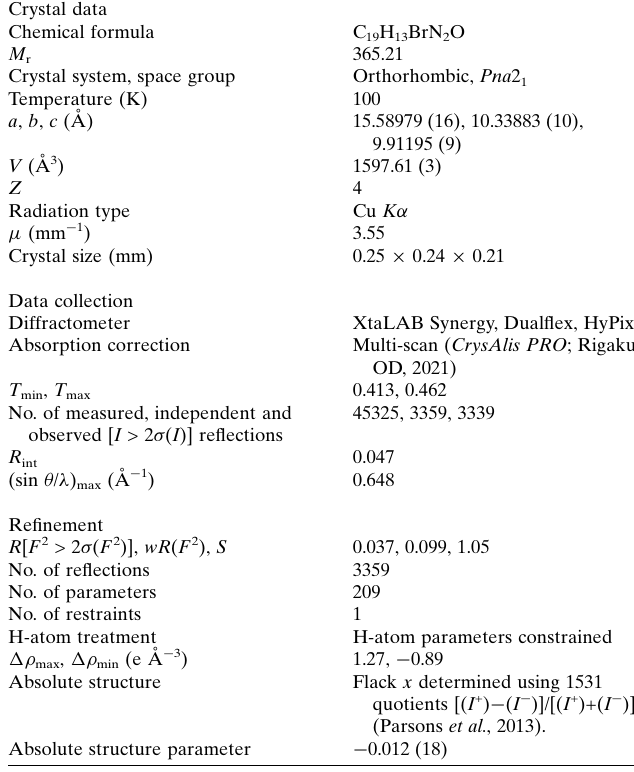
Table 2 Summary of short interatomic contacts (A˚ ) in the title compound. Contact Distance Symmetry